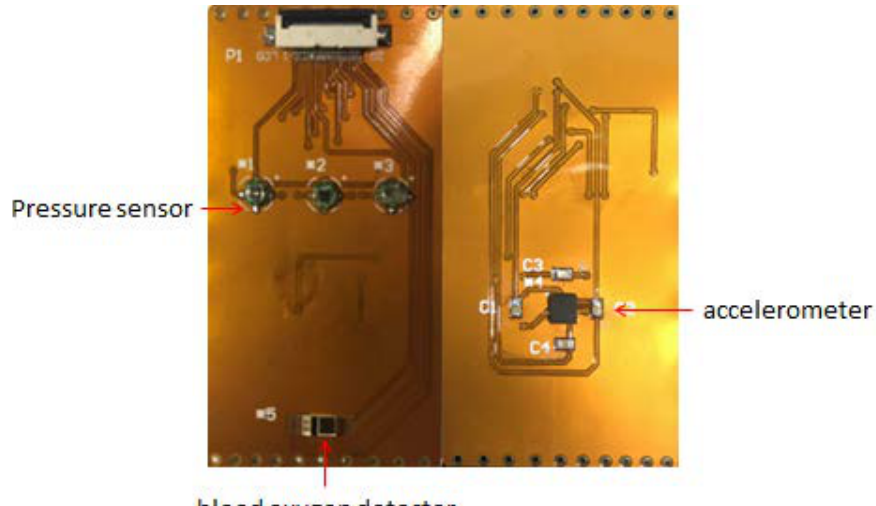
Figure 7. The flexible PCB.